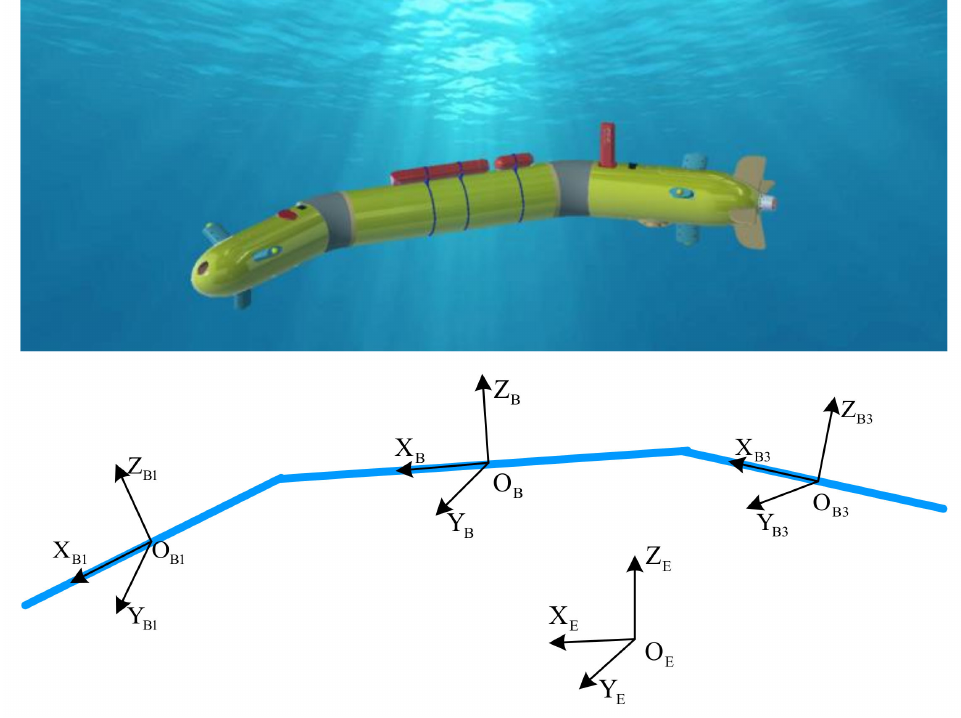
Figure 1. Reference frames of the MJ-AUV.